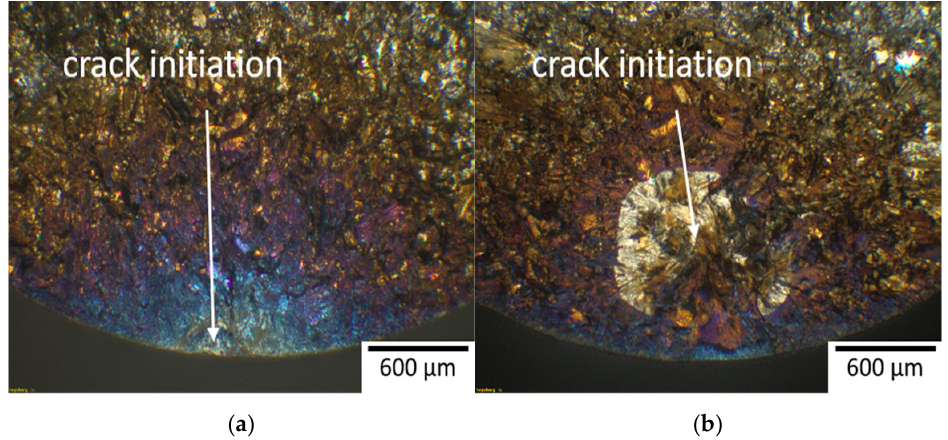
Figure 6. S-N diagram of the untreated and SP material at 750 °C showing a bimodal lifetime distribution at a load of 260 MPa.